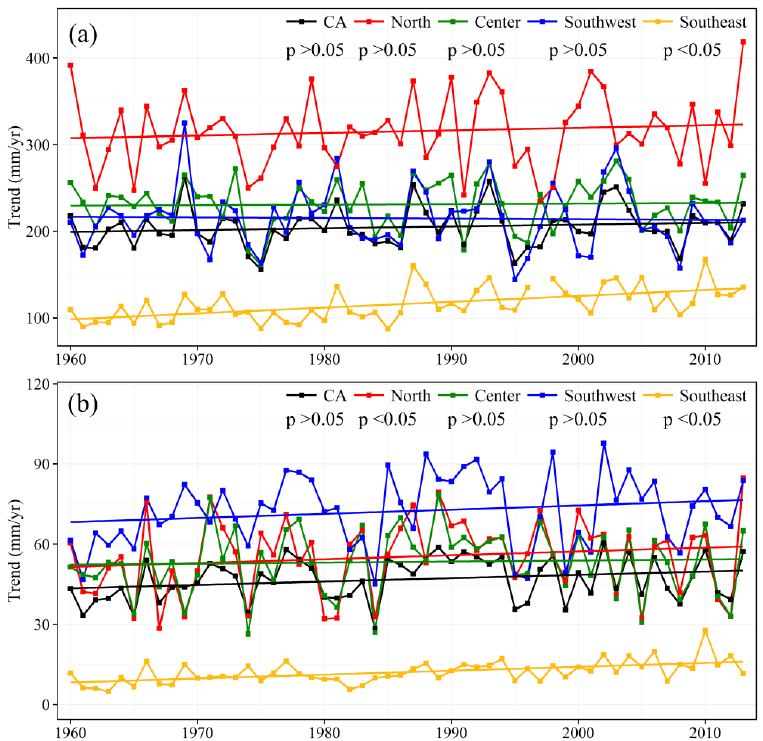
Figure 7. Variations in annual precipitation (mm/year) of Central Asia (CA) and four subregions from 1960-2013. ( a ) Annual; ( b ) Winter. Table 3. Trends in annual and seasonal precipitation (mm/year) for Central Asia (CA) and four subregions from 1960–2013.